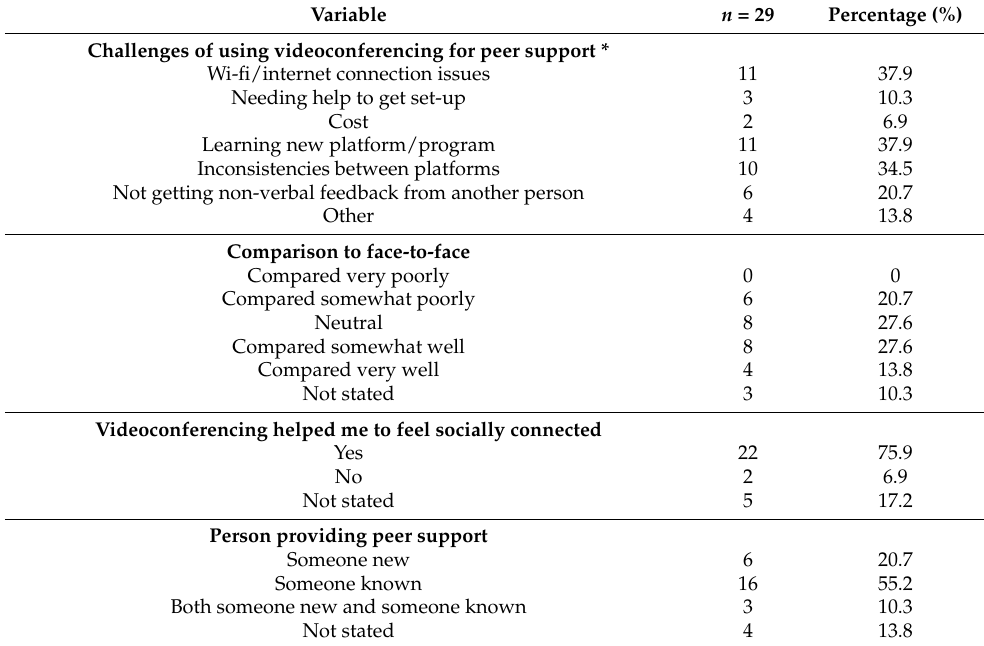
Table 2. Cont. Variable n = 29 Percentage (%) Challenges of using videoconferencing for peer support * Wi-fi/internet connection issues